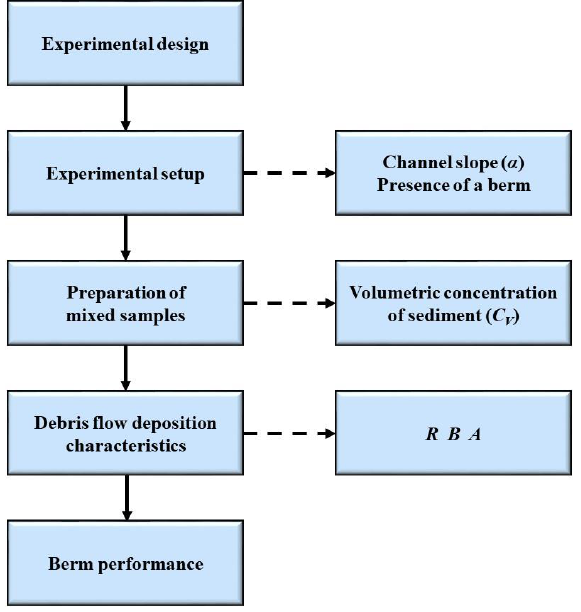
Figure 4. Flow chart of laboratory tests.